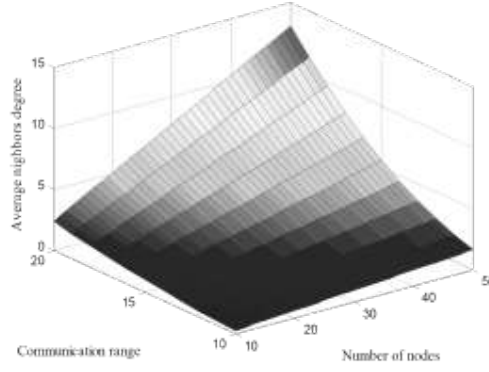
Figure 3. Average neighbors degree in r=[10,20], N=[10,50] and